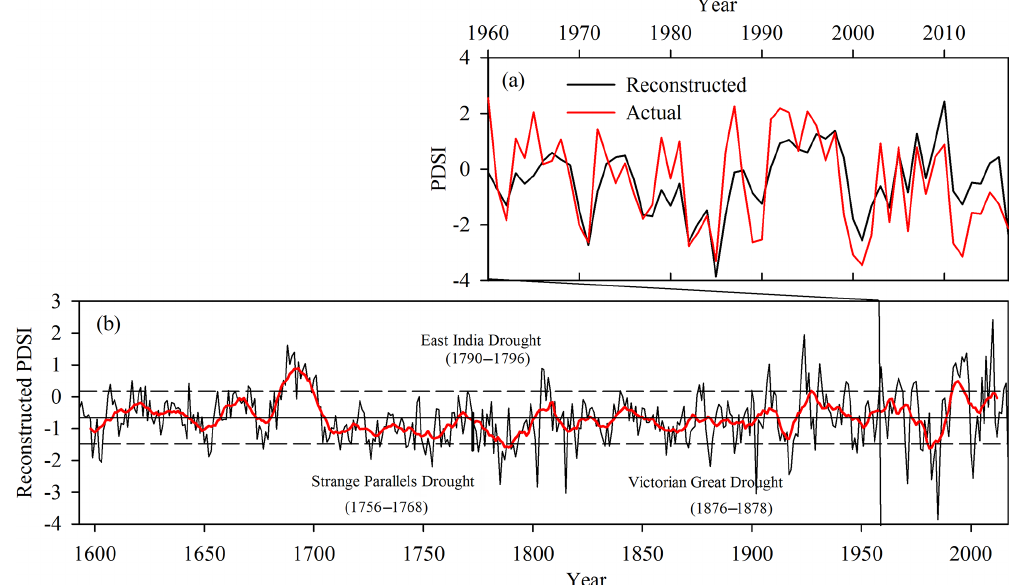
Figure 5. The scPDSI reconstruction in the Chitral Hindu Kush mountains, Pakistan. (a) Comparison between the reconstructed (black line) and actual (red line) scPDSI; (b) the variation of the annual (black solid line) and 11-year moving average (red bold line) Mar–Aug scPDSI from 1593 to 2016 with the mean value ± 1 standard deviation (black dashed lines).